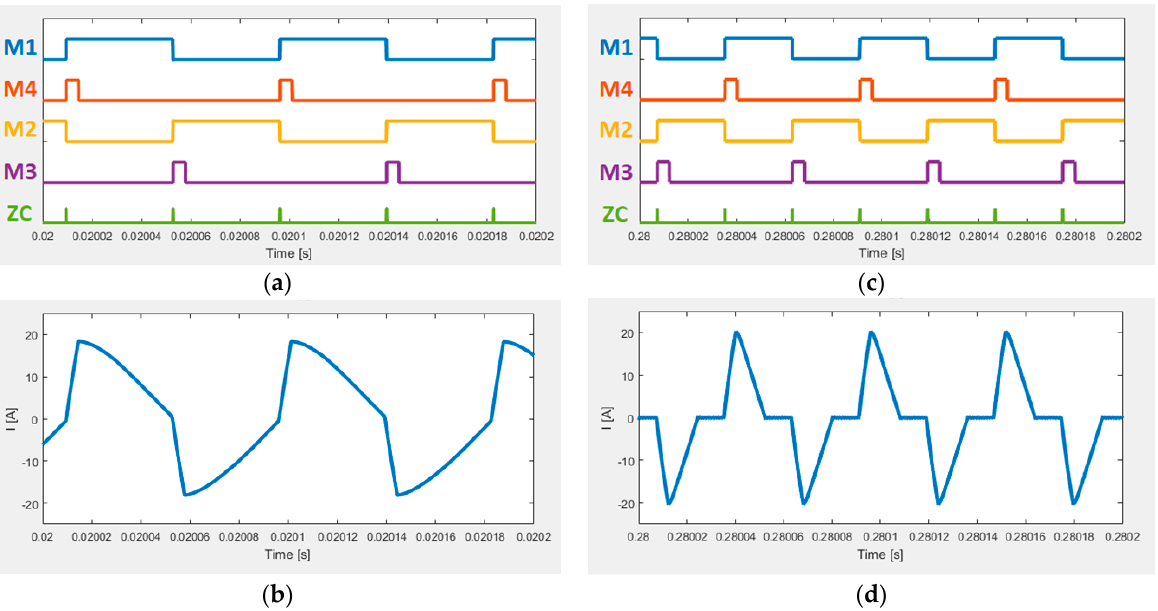
Figure 10. Transistors control signals (M1–M4), current zero-crossing signal (ZC) ( a ), current flowing through the primary winding ( b ) in beginning at the charging and transistors control signals (M1–M4), current zero-crossing signal (ZC) ( c ), current flowing through the primary winding ( d ) at a later stage of charging.